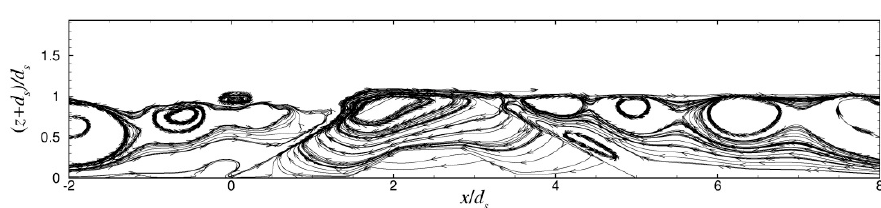
Figure 15. Streamlines in the vicinity of ZFB case 5.